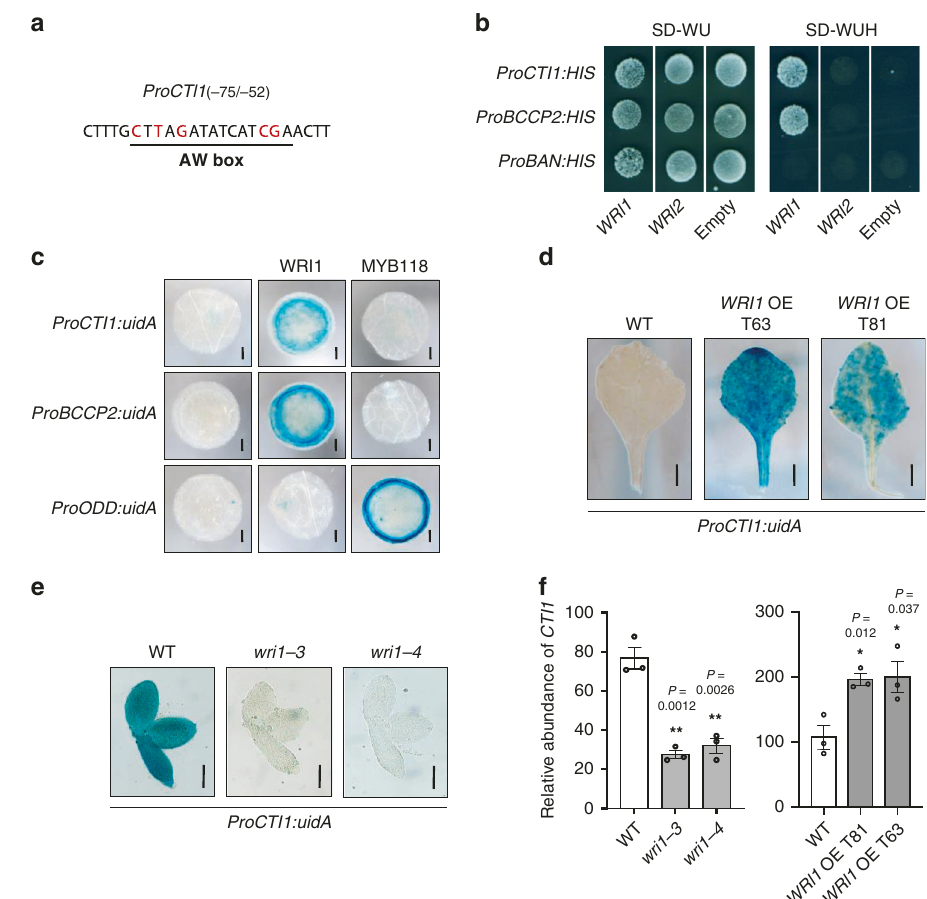
Fig. 4 WRINKLED1 enhances CTI1 expression through direct binding to the CTI1 promoter. a AW cis -regulatory element present in the CTI1 promoter. Conserved nucleotides denoting the presence of an AW box are in red. The numbers between brackets indicate the position of the element relative to the start codon. b WRI1 directly activates the CTI1 promoter in yeast one-hybrid assay. Yeast strains containing the HIS3 reporter gene under the control of either the BANYULS ( BAN , negative control), BCCP2 (positive control), or CTI1 promoter were transformed with either the empty expression vector or with versions of the vectors allowing expression of WRI1 or WRI2 (negative control) before being plated on synthetic dropout (SD-WU or SD-WUH) media. The experiment was repeated fi ve times (with independent clones) with similar results. c WRI1 activates the promoter of CTI1 in transactivation assay in leaves of Nicotiana benthamiana . Pro:uidA reporter constructs ( ProBCCP2 was used as positive control, ProODD as negative control) alone or in combination with a vector allowing the expression of WRI1 or MYB118 (negative control) were coin fi ltrated in young leaves of N. benthamiana . The experiment was repeated twice with similar results. For each experiment and for each condition tested, six independent in fi ltrations were realized. Representative pictures are displayed. Bars = 2 mm. d Activity of the ProCTI1(994 bp):uidA cassette in rosette leaves of Pro35Sdual:WR1 over-expressing (OE) lines ( WRI1 OE T63 and T81) and in a wild-type (WT) background. The experiment was repeated twice (using independent ProCTI1(994 bp):uidA transformants) with similar results. For each experiment and for each genotype, six different leaves were observed. Representative pictures are displayed. Bars = 5 mm. e Activity of the ProCTI1(994 bp):uidA cassette in wri1 mutant embryos and in a WT embryo. The experiment was repeated twice (using independent ProCTI1(994 bp): uidA transformants) with similar results. For each experiment and for each genotype, 10 different embryos were observed. Representative pictures are displayed. Bars = 150 µ m. f Accumulation levels of CTI1 transcripts in seeds of wri1 and in leaves of two independent WRI1 overexpressing lines ( WRI1 OE T81 and T63) analyzed by qRT-PCR. The results obtained are standardized to the constitutive EF1 α A4 gene expression level. Data are means ± SEM, n = 3 biologically independent plants. Asterisks indicate signi fi cant difference from the wild-type control as determined by a two-tailed Student ’ s t- test at ** P < 0.01 and * P < 0.05,